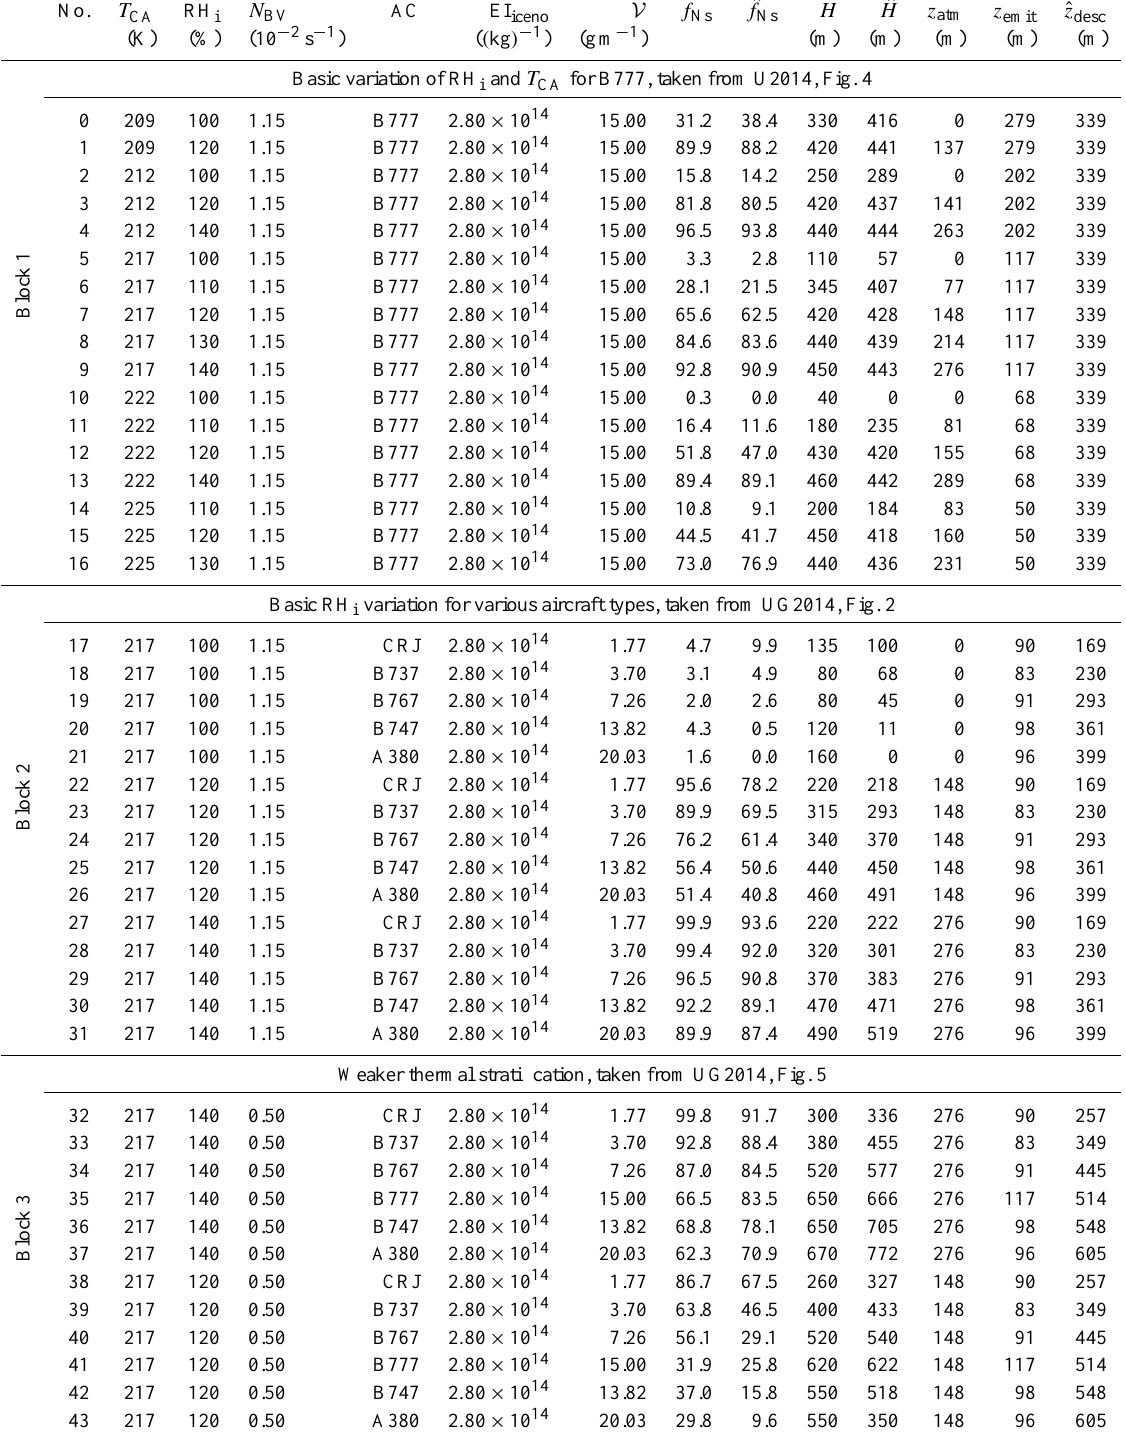
Table A2. List of simulations. Columns 2–7 list parameter settings, columns 8–11 the simulated and approximated values for survival fraction and contrail depth, and columns 12–14 the values of three characteristic length scales. “ − 1” indicates missing values. The aircraft (AC) type defines the wake vortex properties and water vapour emission as listed in Table